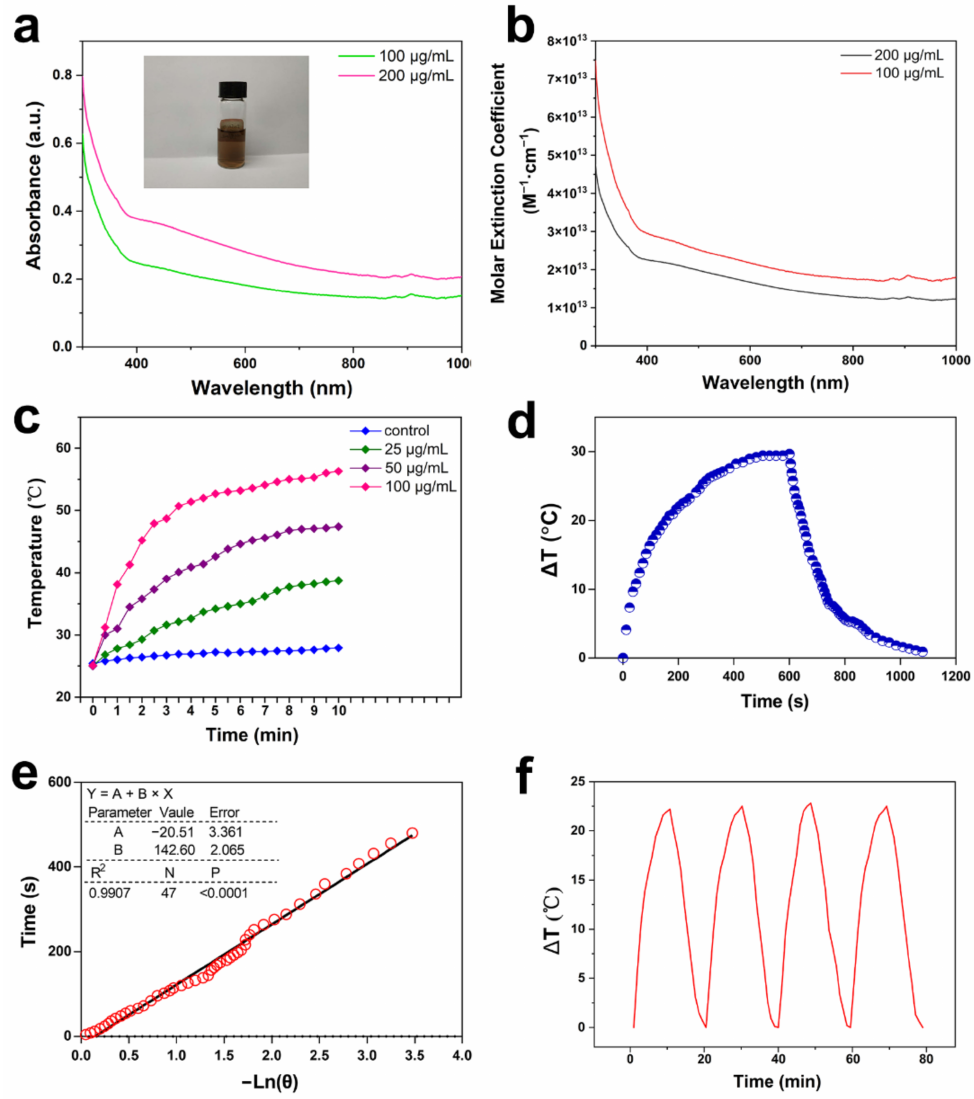
Figure 2. Photothermal profile of Bi 2 Se 3 . ( a ) Room-temperature UV–Vis-NIR absorbance spectra for the Bi 2 Se 3 dispersed in deionized water (100, 200 µ g/mL). The Insertedphoto shows 100 µ g/mL Bi 2 Se 3 dispersion; ( b ) the extinction coefficient ( ε ) of Bi 2 Se 3 particles (100, 200 µ g/mL); ( c ) Tem- perature elevation curve of Bi 2 Se 3 dispersion under 808 nm laser (0.21 W/cm 2 ); ( d ) Photothermal effect of Bi 2 Se 3 dispersion (100 µ g/mL) with laser irradiation (808 nm, 0.21 W/cm 2 ). The laser was removed after irradiation for 600 s; ( e ) The calculation of the heat conversion efficiency ( η ) of Bi 2 Se 3 dispersions (100 µ g/mL); ( f ) Photostability test curve of Bi 2 Se 3 (50 µ g/mL) within four laser on/off cycles (0.21 W/cm 2